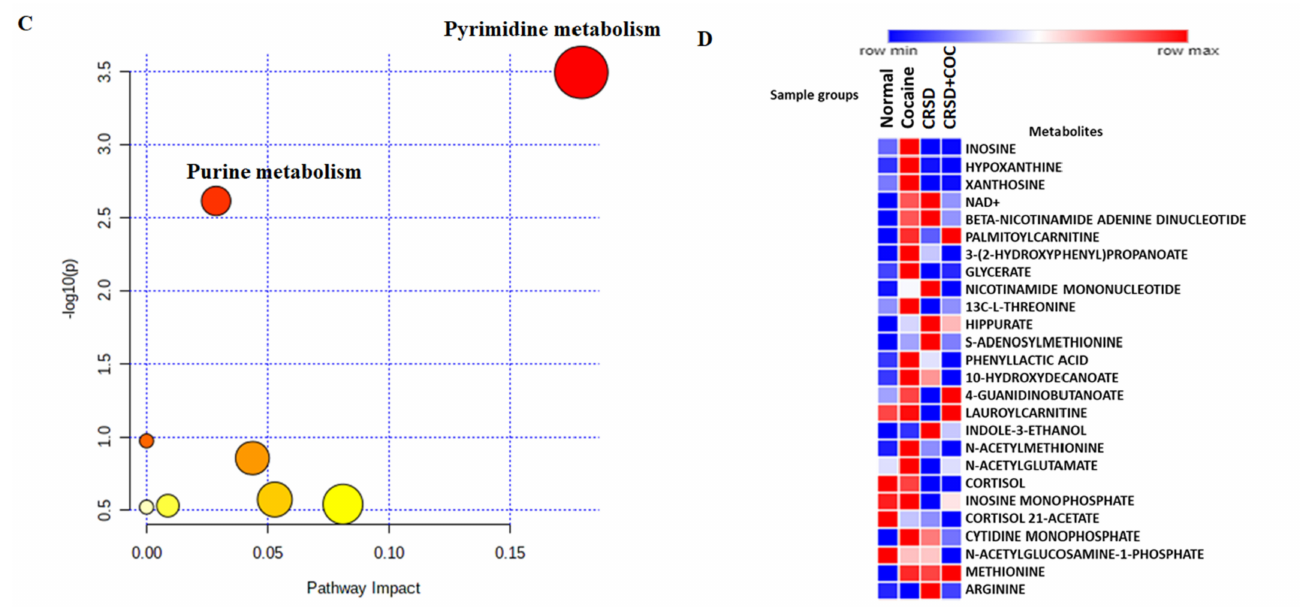
Figure 6. Functional analysis of the common significantly altered metabolites. ( A ) The involvement of metabolites in various pathways were investigated using enrichment pathway analysis. A list of the most enriched pathways in which these metabolites are involved is shown based on the enrichment ratio. ( B ) The involvement of metabolites in various pathways was investigated using enrichment pathway analysis. A list of the most enriched pathways in which these metabolites are involved is shown based on − log10( p value). ( C ) The pathway impact is shown based on − log10( p value). ( D ) Heatmap showing the top upregulated metabolites (red) and downregulated metabolites (blue) across the control, circadian disruption (CRSD), cocaine, and CRSD with cocaine treatment groups.